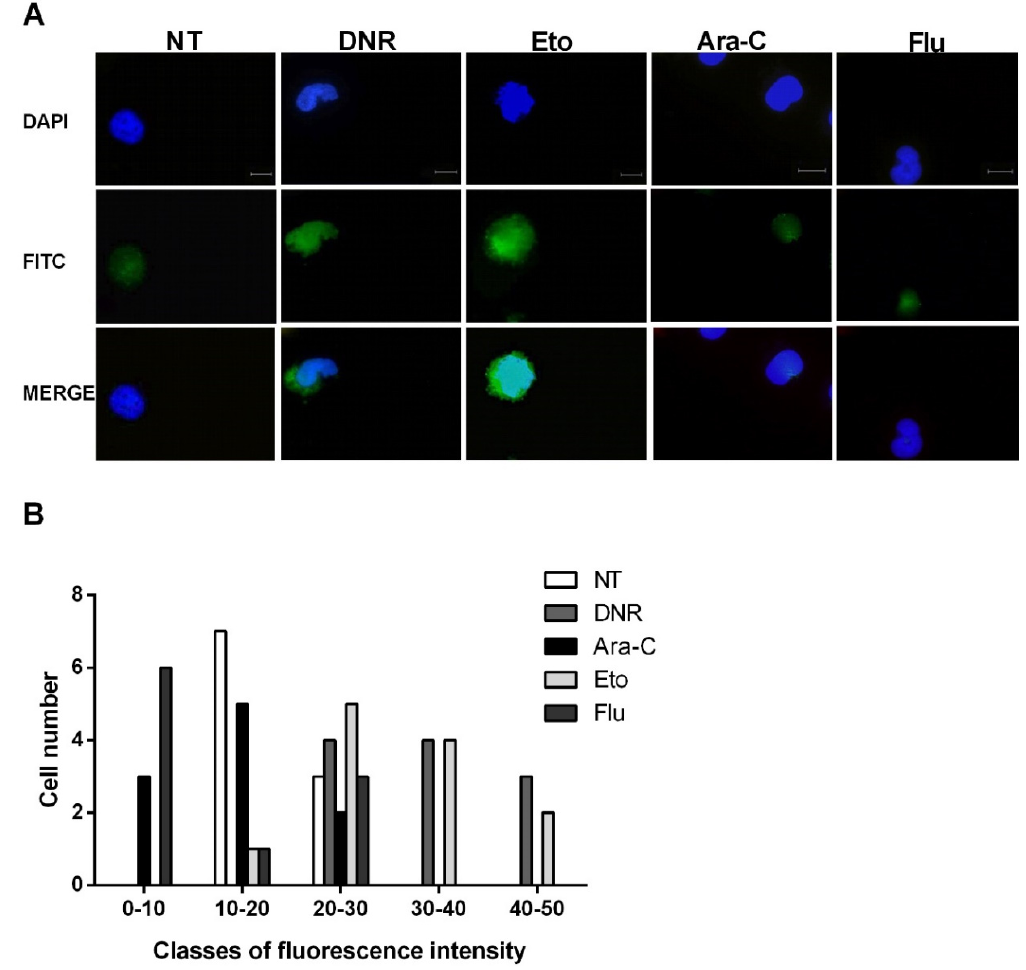
Figure 4. Immunofluorescence analysis of non-histone chromatin-binding protein high mobility group box 1 (HMGB1) release from the nucleus of HL-60 cell lines after chemotherapy treatment. The HL-60 cells were treated or not (no treatment; NT) with daunorubicin (DNR) (500 ng/mL), cytarabine (Ara-C) (20 µg/mL), etoposide (Eto) (20 µg/mL) and fludarabine (Flu) (70 µg/mL) for 24 h. ( A ) The release of HMGB1 (FITC-conjugated) from nucleus (DAPI-conjugated) to cytoplasm and then extracellular space was visualized by immunofluorescence microscopy. One representative experiment for each drug is reported. Bar 20 µm. ( B ) Quantitative analysis of HMGB1 fluorescence intensity outside the nucleus in un-treated and treated HL-60 cells. A representative field was used for quantification. The signal outside the nucleus was measured by densitometry ( n = 21; randomly selected cells). The cells are grouped in classes of fluorescence intensity and plotted relative to HMGB1 expression.